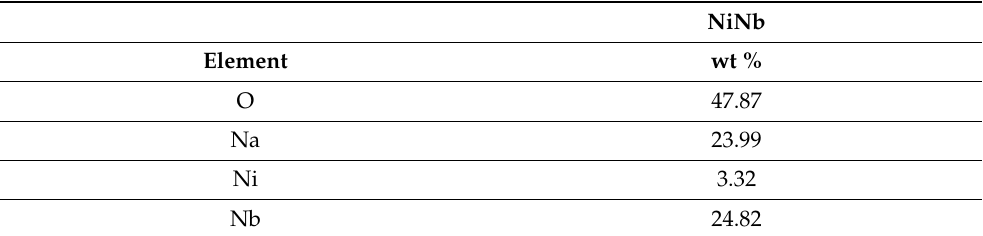
Table 2. Chemical composition of NiNb catalyst obtained by EDX (average values, weight percent,